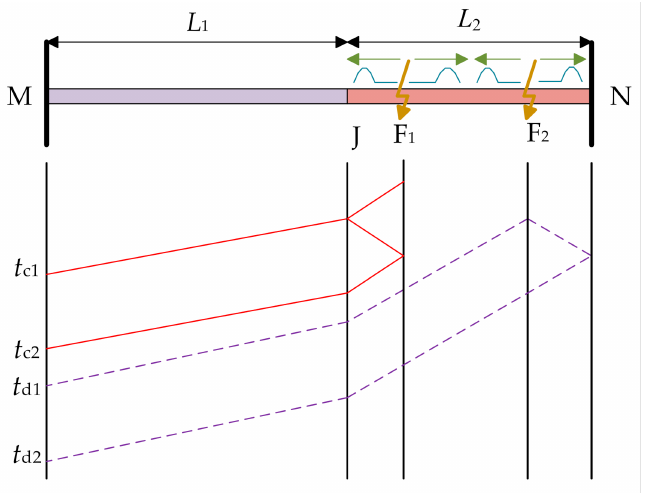
Figure 5. Fault traveling wave propagation on different